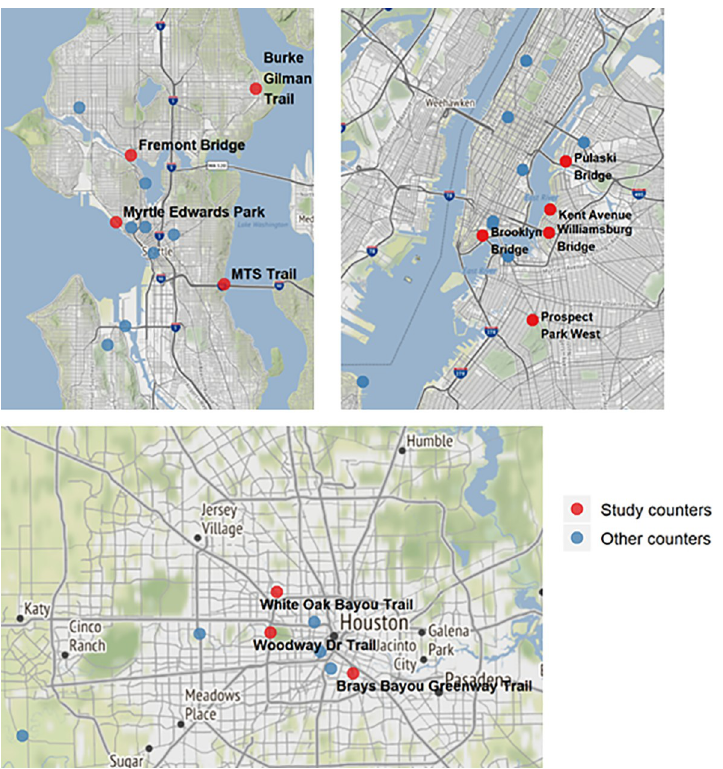
Fig 1. Location of bicycle counters in Seattle (top left) [11], New York City (top right) [12], and Houston (bottom) [13]. Study counters (in red) are the counters included in the analysis, and other counters (in blue) are all other bicycle/pedestrian counters in each city not included in the analysis due to incomplete data. Base maps and data from © OpenStreetMap contributors and OpenStreetMap Foundation. Contains information from OpenStreetMap and OpenStreetMap Foundation, which is made available under the Open Database